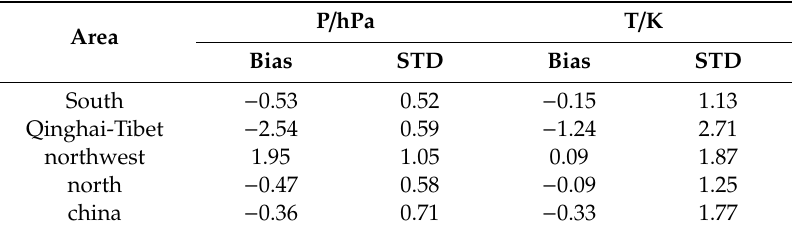
Figure 2. Standard Deviation (STD) and bias distributions of P and T derived from ERA5 and ERA-Interim at grid points over the period of 2005–2016 in China. Table 2. Statistical results of Standard Deviation (STD) and bias of P / hPa and T / K in four regions of China.